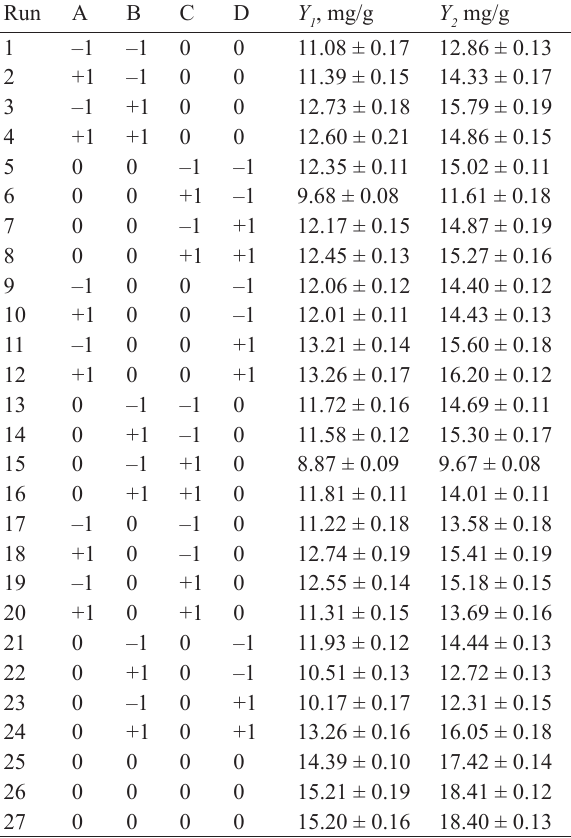
Table 2 Experimental design and response